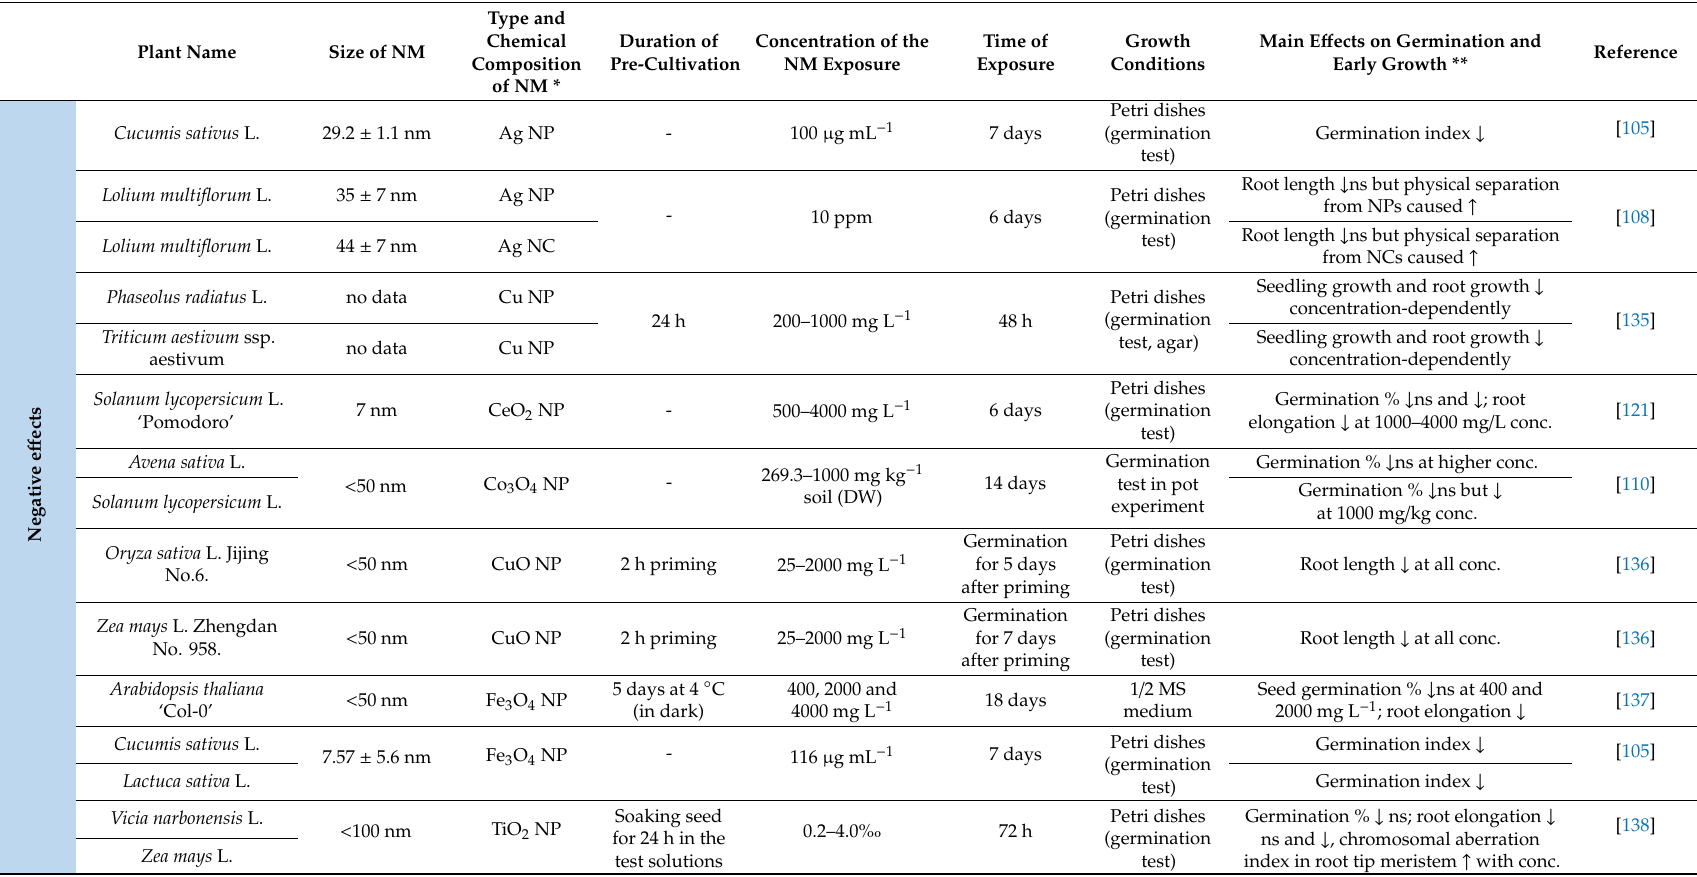
Table 3. Negative e ff ects of metal and metal oxide NPs on seed germination and seedling